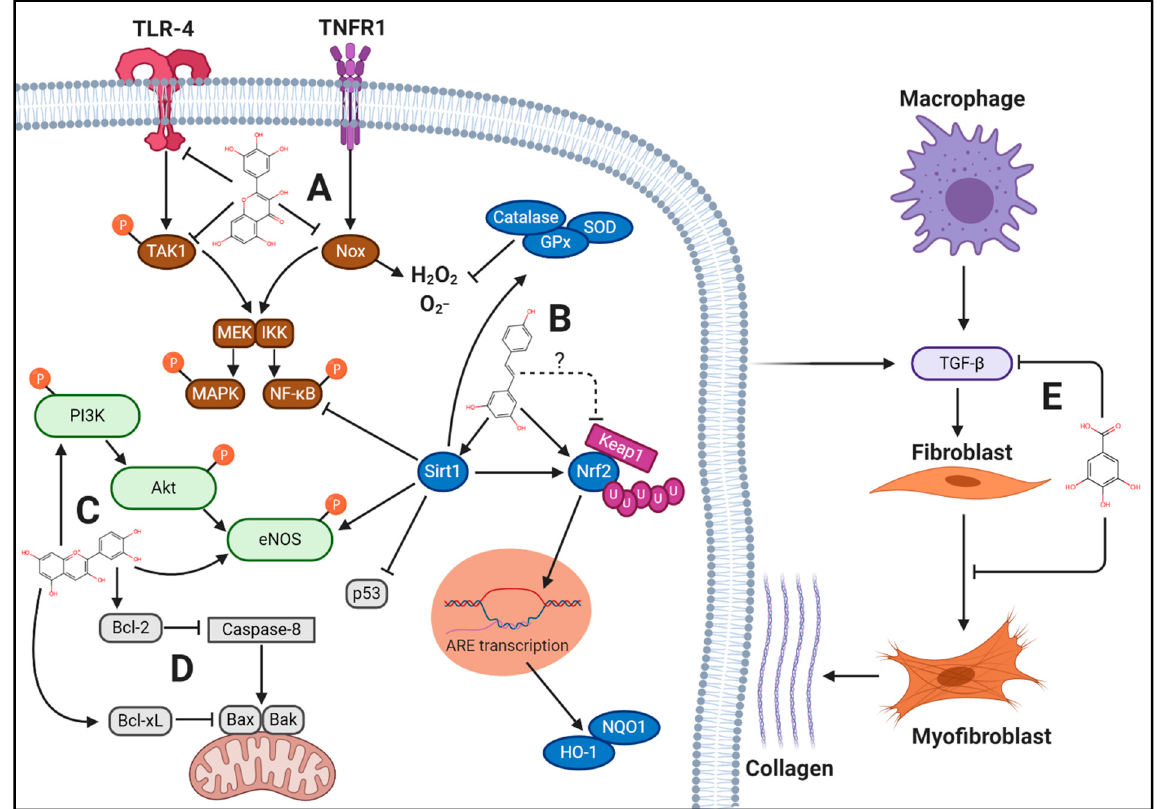
Figure 1. Mechanisms of Berry Polyphenols in CVD . Polyphenols found in berries can attenuate the pathological cellular processes of cardiovascular disease (CVD) in a multi-targeted manner. ( A ) Berry polyphenols, such as myricetin, reduce inflammation by decreasing toll-like receptor (TLR)-4 activation and phosphorylation of transforming growth factor- β (TGF- β )-activated kinase 1 (TAK1) while also mitigating tumor necrosis factor receptor 1 (TNFR1)-dependent NADPH-oxidase (Nox) activation. Thus, phosphorylation of mitogen-activated protein kinase kinase (MEK) and I κ B kinase (IKK) and redox modifications are reduced, preventing downstream activity of mitogen activated protein kinase (MAPK) and nuclear factor kappa-light-chain-enhancer of activated B (NF- κ B), respectively. ( B ) Berry polyphenols, such as resveratrol, reduce oxidative stress by increasing nuclear factor erythroid 2-related factor (Nrf2) protein expression via a number of mechanisms, of which include possible reduction of kelch-like ECH-associated protein 1 (Keap1) binding affinity to Nrf2, reducing Keap1-mediated ubiquitination. Increased Nrf2 nuclear translocation results in increased transcription of heme oxygenase (HO)-1 and NADPH quinone dehydrogenase (NQO1) due to antioxidant responsive element (ARE) transcriptional activity. Additionally, berry polyphenols increase sirtuin 1 (Sirt1) protein expression, which targets a number of proteins, reducing NF- κ B and p53 activity while increasing Nrf2 and endothelial nitric oxide synthase (eNOS) activity. Further, Sirt1 increases antioxidant enzymes superoxide dismutase (SOD), glutathione peroxidase (GPx), and catalase, which neutralize superoxide O 2 − and H 2 O 2 . ( C ) In endothelial cells, berry polyphenols, such as cyanidin, increase phosphoinositide 3-kinase (PI3K) activity, resulting in increased phosphorylation of protein kinase B (Akt) and eNOS, resulting in increased nitric oxide (NO), promoting vasodilation. Additionally, berry polyphenols preserve eNOS protein expression under a number of pathological stimuli, including due to TNFR1 activation. ( D ) Berry polyphenols reduce apoptosis by increasing B-cell lymphoma 2 (Bcl-2), reducing caspase-8 mediated activation of Bcl-2-associated X protein (Bax) and Bcl-2 homologous antagonist killer (Bak), while Bcl extra-large (Bcl-xL) reduces Bax/Bak oligomerization. ( E ) Berry polyphenols, such as gallic acid, reduce fibrosis by decreasing TGF- β protein expression and prevent fibroblast differentiation to myofibroblasts, resulting in reduced collagen synthesis. Created in BioRender.com.